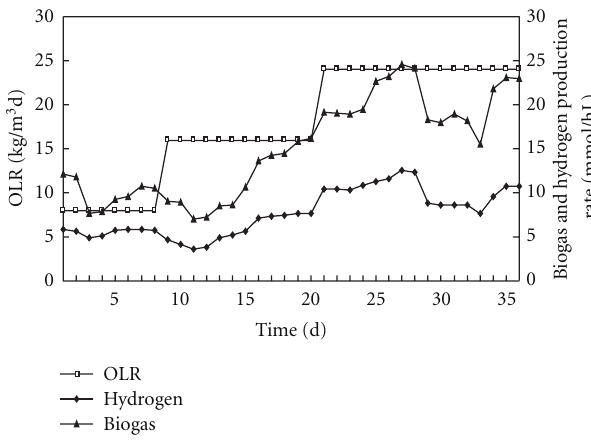
Figure 2: The time series of gaseous accumulation in fermentation